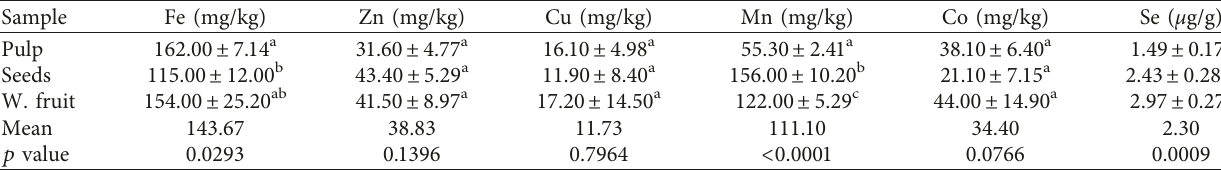
Table 2: Trace element composition in the fruit of Tetrapleura tetraptera .